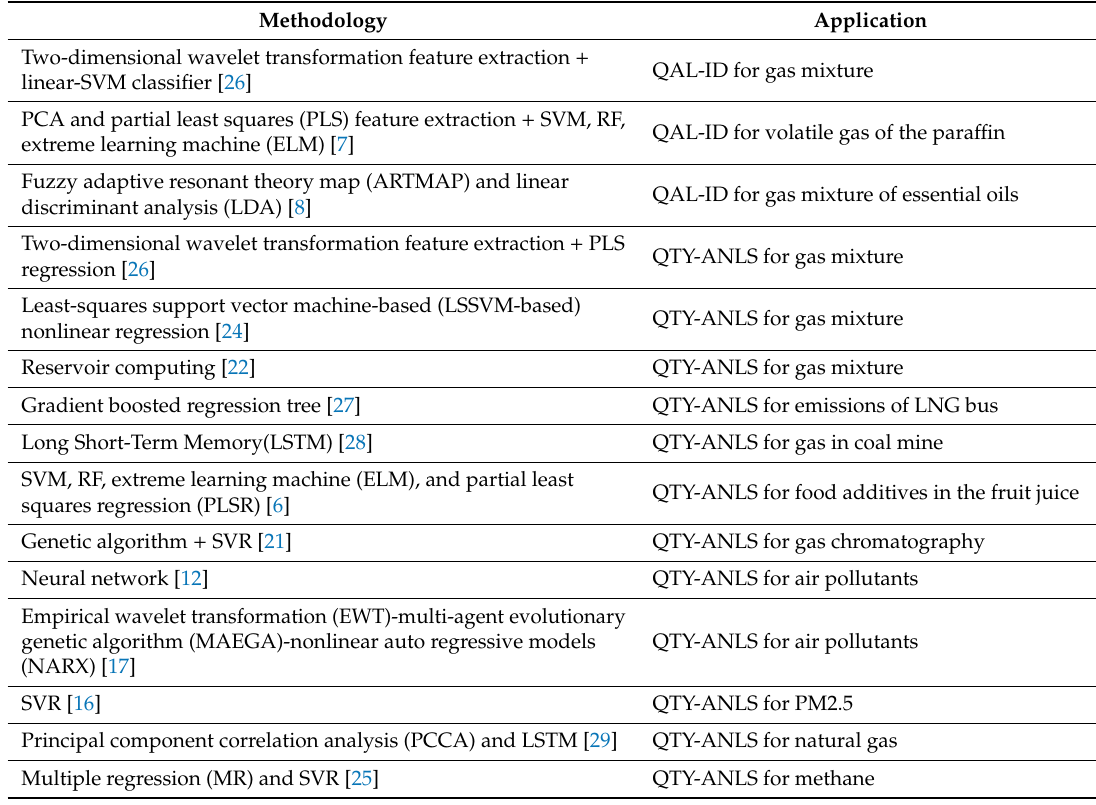
Table 1. Summary of gas mixture analysis